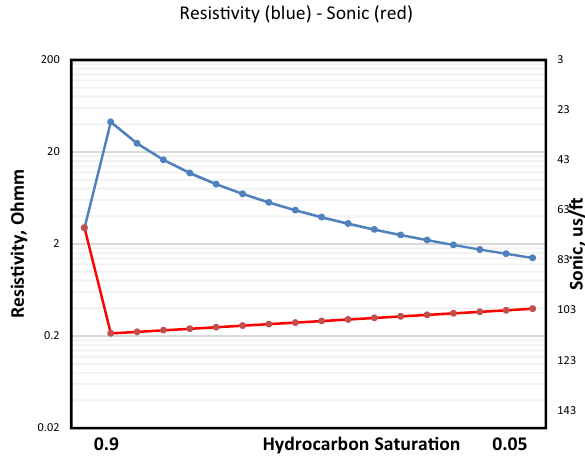
Table 6 Rock responses with clay effect, V